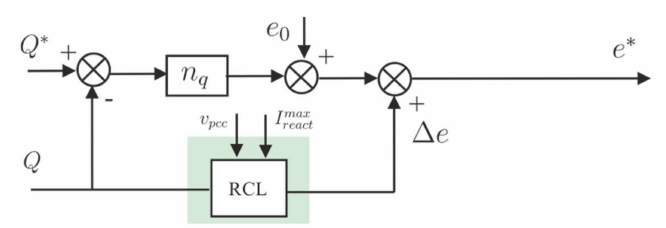
Figure 3. Reactive power